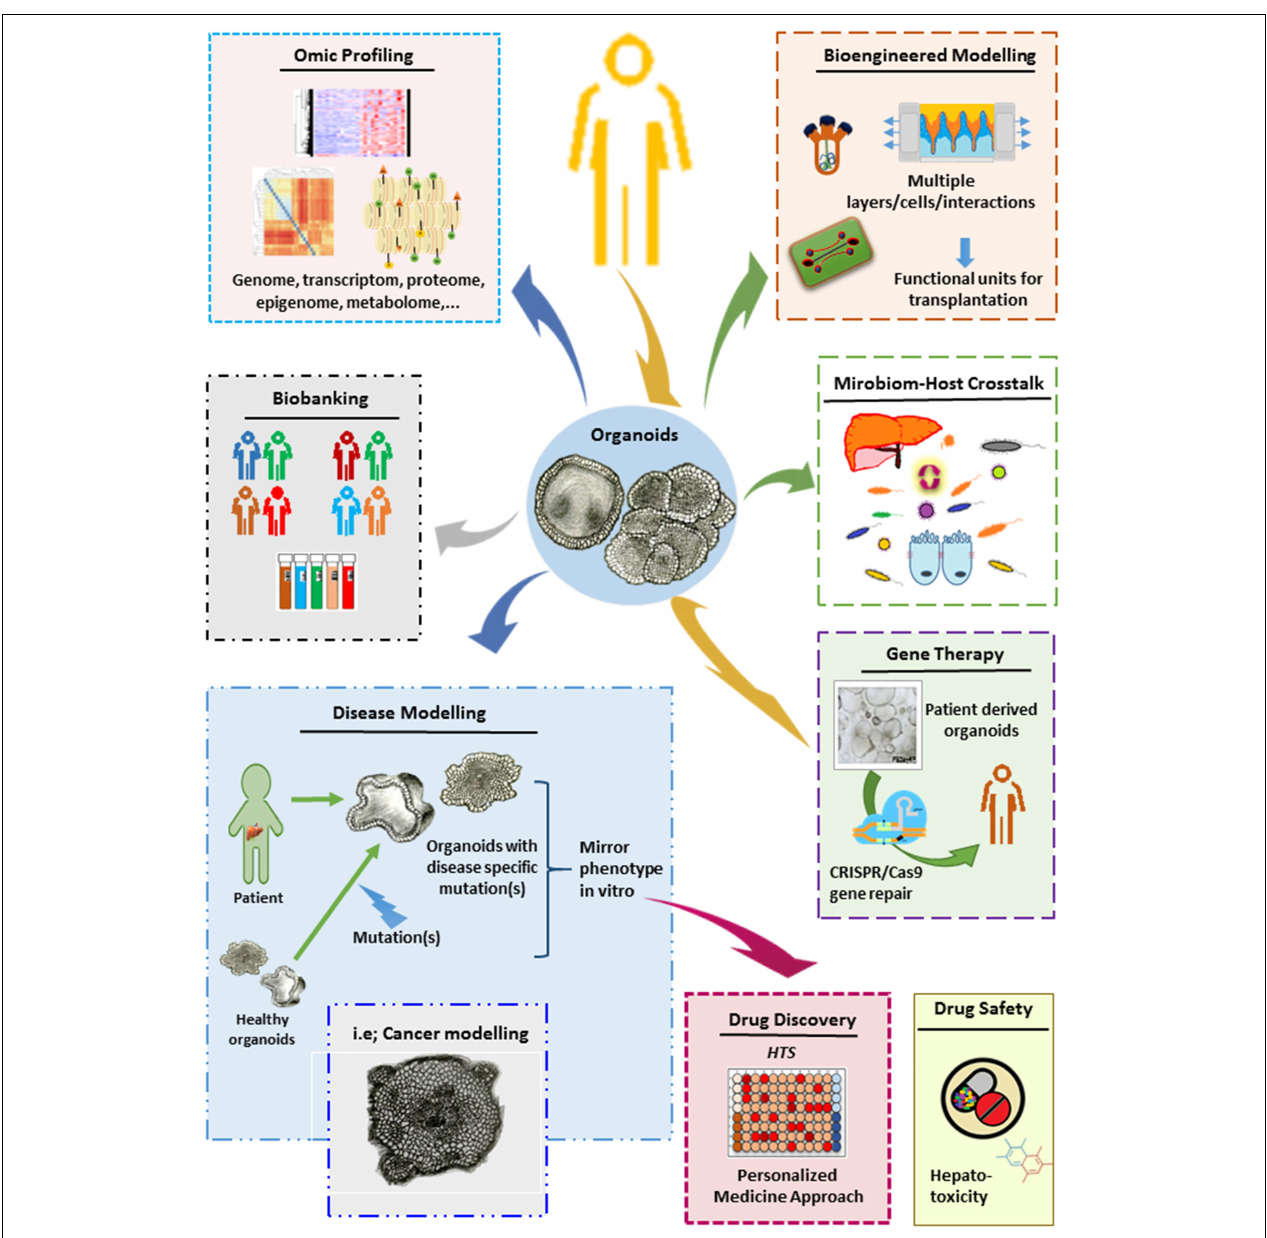
FIGURE 3 | Potential applications for liver